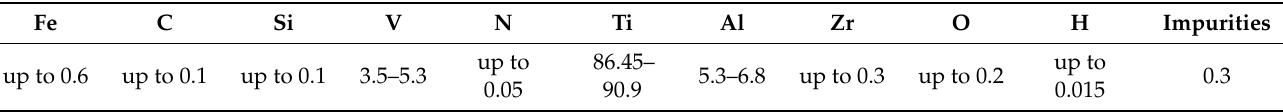
Table 1. Chemical composition of the Ti-6Al-4V alloy (in weight %).